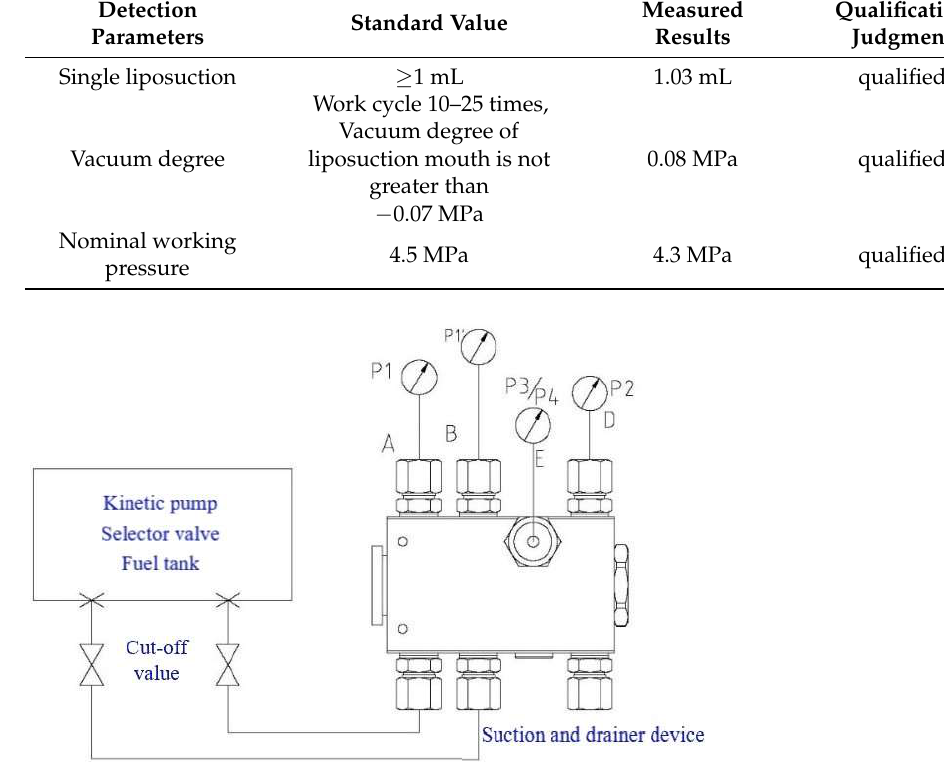
Table 1. Test standards and experimental data.